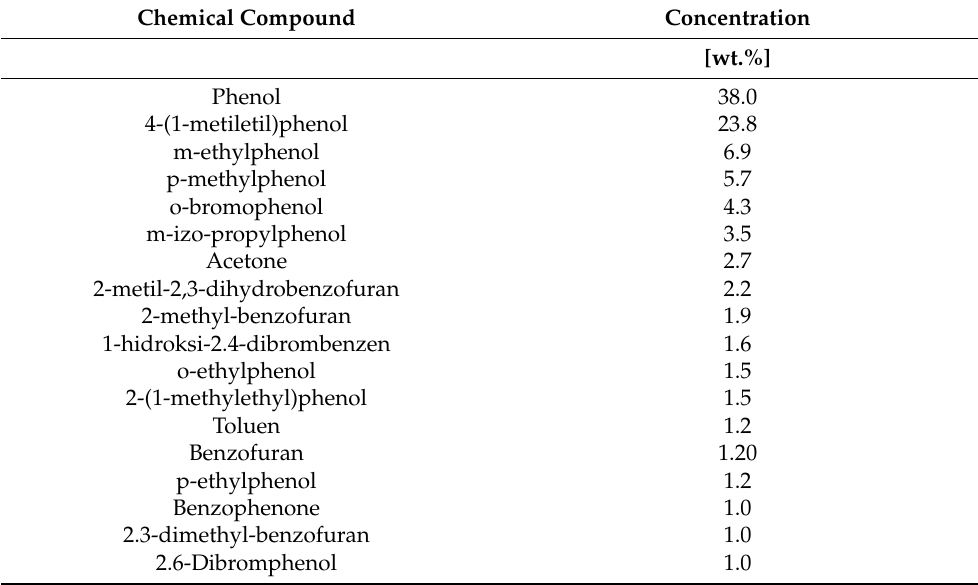
Table 16. Chemical composition of pyrolytic